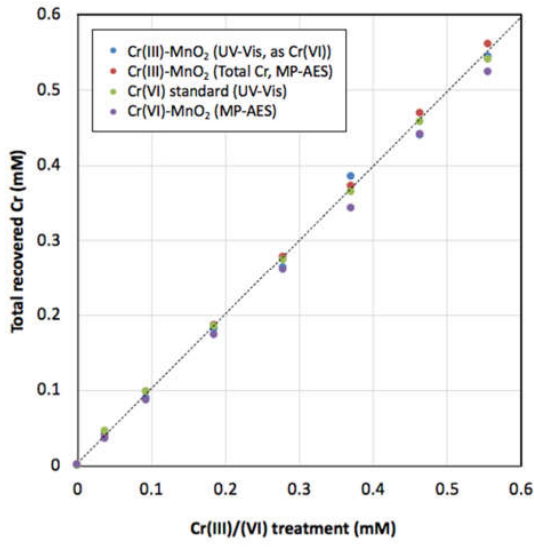
Figure 8. Recovery of Cr as Cr(VI) (UV–Vis spectrophotometry) and total Cr (microwave plasma– atomic emission spectrometry (MP–AES)) under the treatment conditions employed in this study. The dashed line represents the 1:1 relationship or 100% recovery.